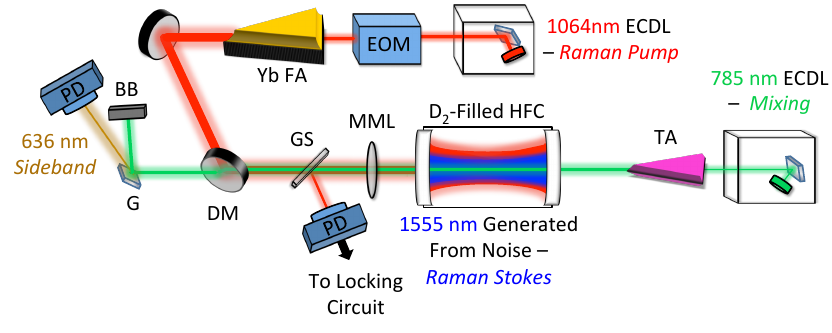
The simplified schematic of our